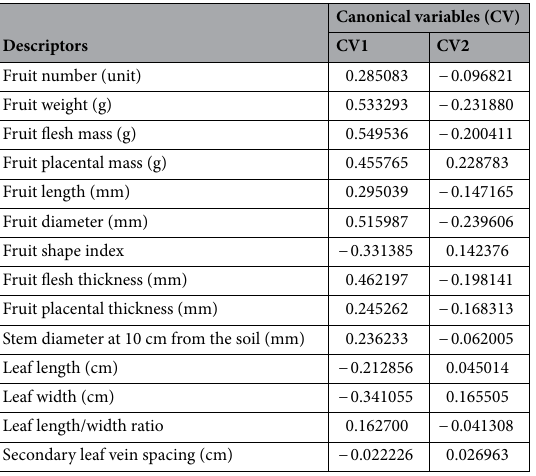
Table 5. Canonical variables of 29 plant descriptors; fruit; leaf; and stem in 61 genotypes of S 1 inbred guava families. UENF, municipality of Campos dos Goytacazes,